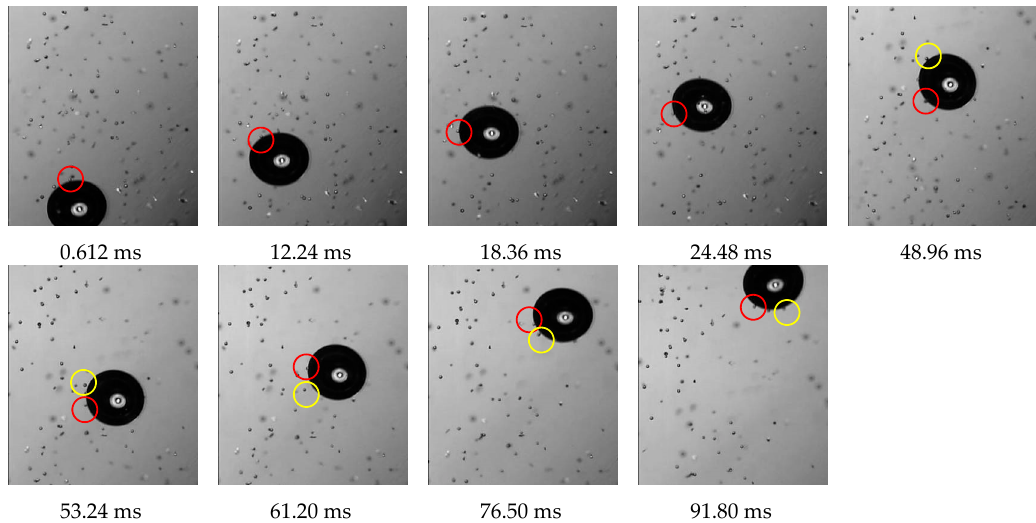
Figure 11. Adhesion between glass microspheres and bubbles.